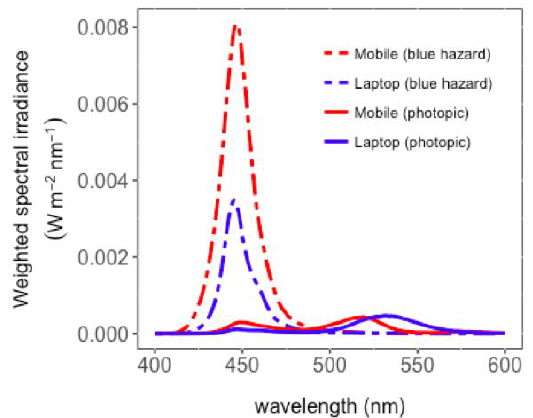
Figure 2. Weighted spectral irradiances for blue light hazard and for photopic vision at 10 cm determined for one laptop and one mobile phone in the sample.